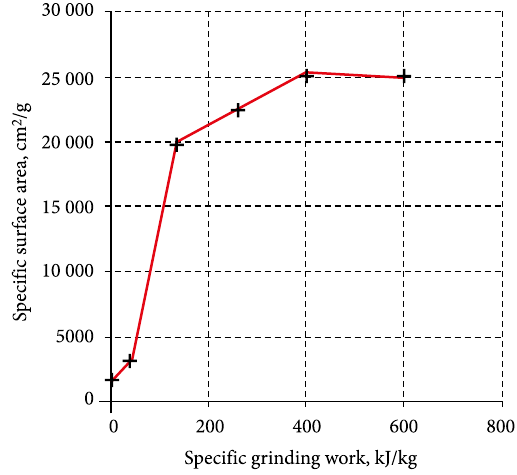
Fig. 2. Variation of specific surface area of fly ash as function of specific grinding work